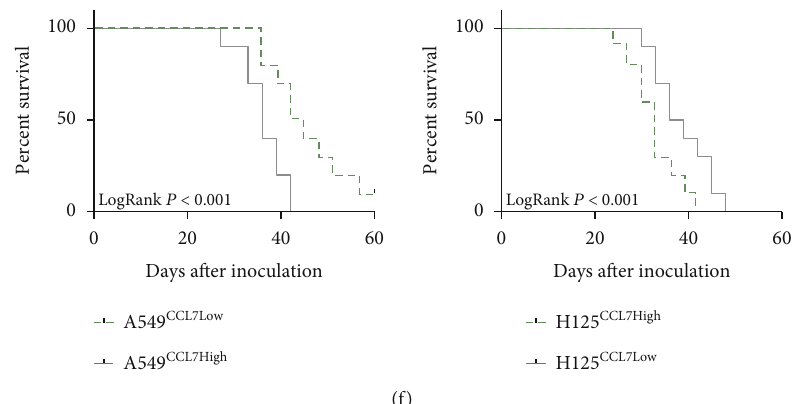
Figure 4: Xenograft tumors formed by CCL7-low cells have reduced macrophage in fi ltration. (a) Images of mouse lung tissues after animal sacri fi ce at 6 weeks after A549 or H125 cell injection; (b and c) portion of F4/80/CD86- or CD206-positive cells in mouse xenograft tumors analyzed by fl ow cytometry; (d and e) staining intensity of CD206 or CD86 in mouse xenograft tumors examined by IHC; (f) survival rate of another 10 mice in each group analyzed by Kaplan-Meier analysis. In panels (a – e), n = 6 , in each group. ∗∗ p < 0 : 01